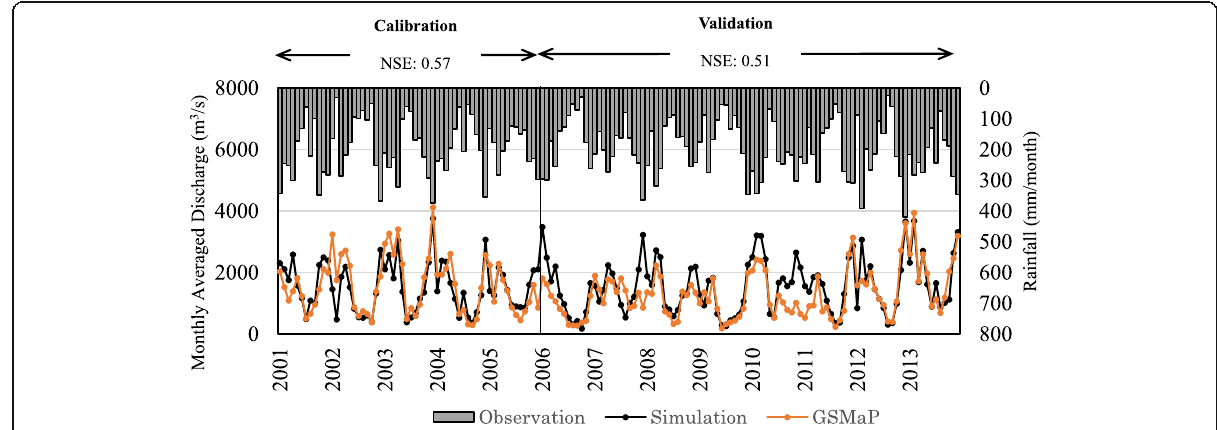
Fig. 6 Comparison of simulated monthly discharge with observations at Muara Tembesi with basin-averaged daily rainfall from